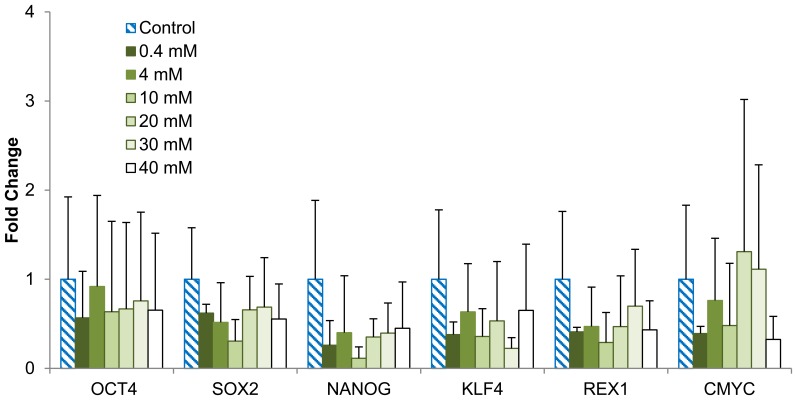
Quantitative PCR analysis of pluripotency markers for hESCs after being cultured in the media supplemented with Mg ion dosages.H9-OCT4 hESCs were cultured for 72 hours and analyzed for expression of the corresponding markers. No statistically significant difference was detected among any of the groups. Values are mean ± standard deviation; n = 9.